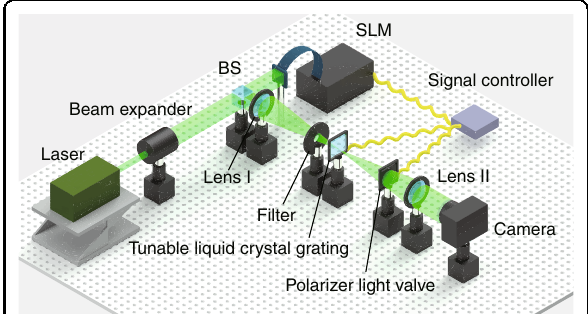
Fig. 2 Optical path structure of the proposed